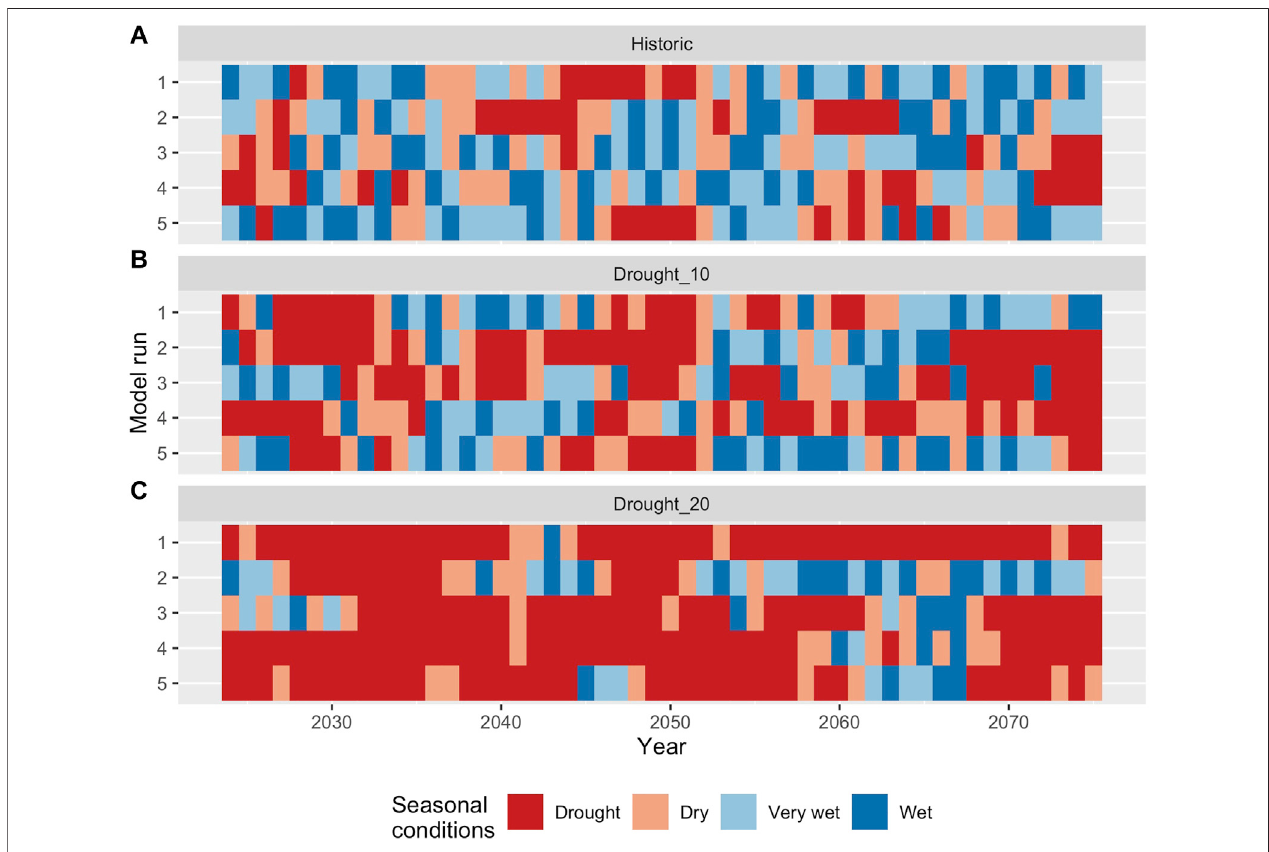
FIGURE3| Hypotheticalfuture fl owsequencesgeneratedusingthestateandtransitiontablesforthehistoricalsequence (A) ,10%increaseindroughtpersistence (B) and 20% increase in drought persistence (C) . Tables 1 , 2 for annual transition probabilities under each scenario.